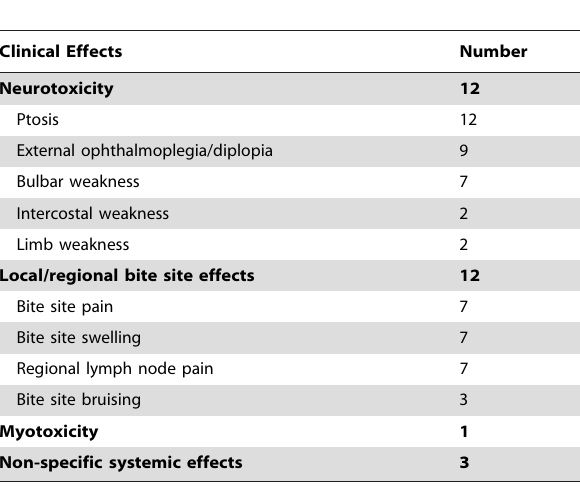
Table 2. Clinical effects in 14 patients with death adder envenoming.